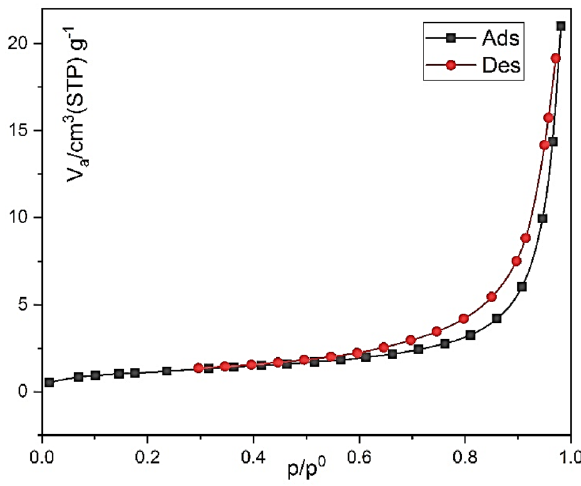
Figure 8. BET analysis of Co-MOF-C (N2 adsorption–desorption isotherm